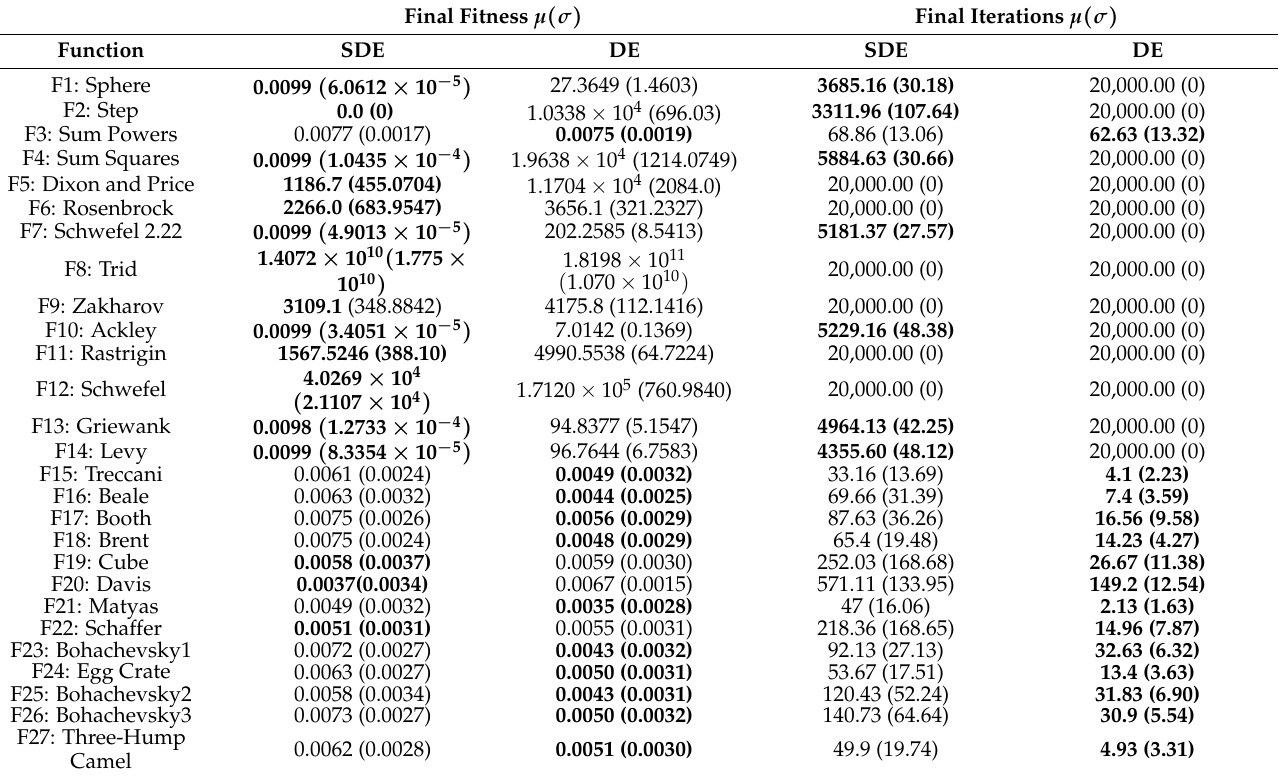
Table 10. Mean and averaged final fitness and iterations of DE and SDE ( N p = 512; D =